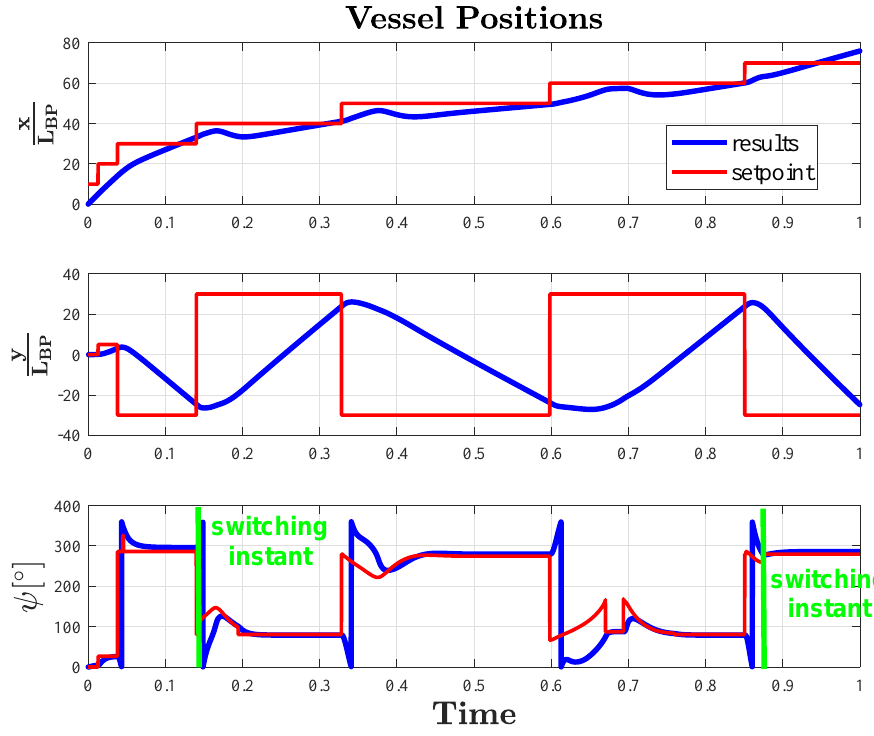
Figure 5. Vessel position and attitude. The green lines represent the switching